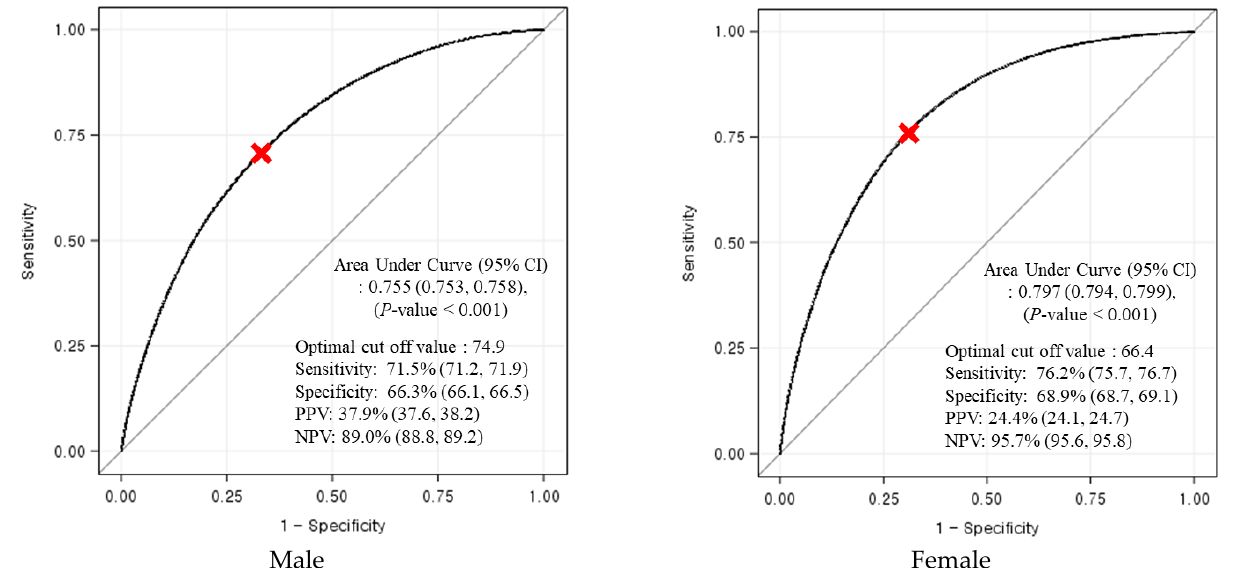
Figure 2. Receiver operating characteristic curve and cut-off values of relative lean body mass in predicting metabolic syndrome. Abbreviations. CI, confidence interval; NPV, negative predictive value; PPV, positive predictive value.